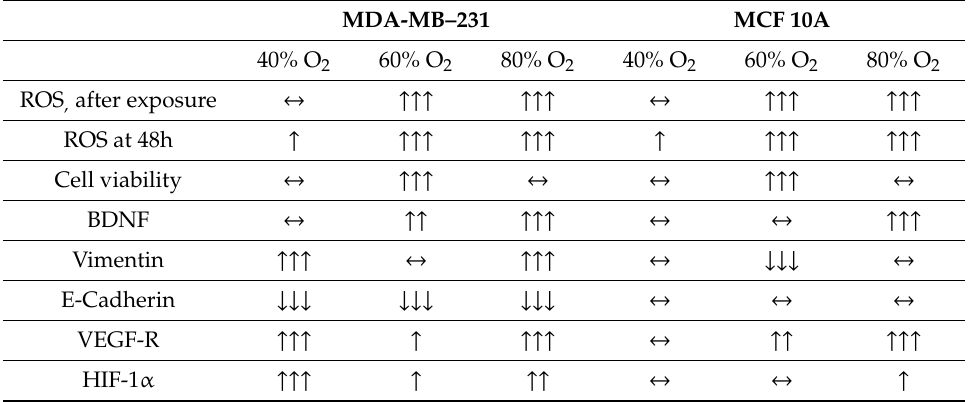
Table 1. The statistical significance of parameters variation in human breast cancer (MDA-MB – 231) and normal epithelial (MCF 10A) cell lines exposed to 40%, 60%, 80% O 2 (reference values-21% O 2 exposure).